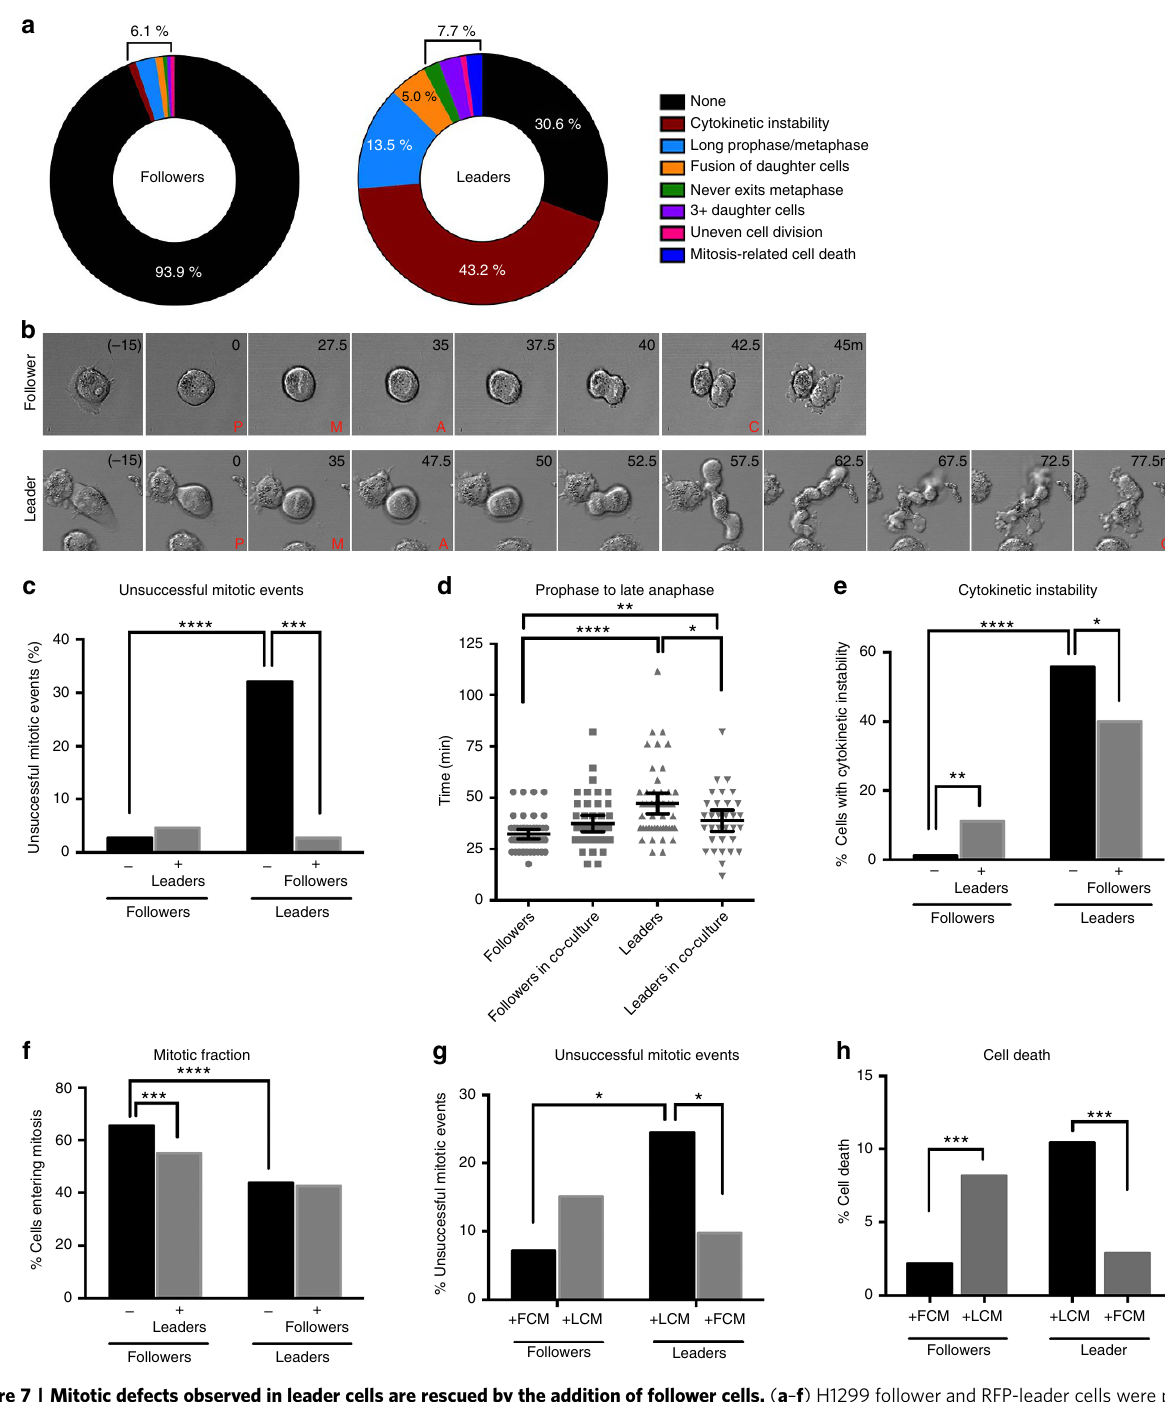
Figure 7 | Mitotic defects observed in leader cells are rescued by the addition of follower cells. ( a – f ) H1299 follower and RFP-leader cells were plated in 2D alone or in a 50:50 mixed co-culture then imaged using live cell confocal microscopy. Mitotic events were analysed in each condition. ( a ) Graphs of each type of mitotic error noted during the live cell imaging as a percentage of all mitotic events. n ¼ 258. ( b ) Still images of a mitotic event in a follower cell and a leader cell. Time in minutes. P, prophase; M, metaphase; A, anaphase; C, cytokinesis. ( c ) Unsuccessful mitotic events were classified and graphed as a percentage of total mitotic events seen in followers, leaders or each cell type in the co-culture condition. n ¼ 506. A two-tailed w 2 -test was used to determine significance. ( d ) Dot plot of the amount of time each cell spent from prophase to the beginning of anaphase. n ¼ 555 cells. A one-way ANOVA with Tukey’s multiple comparisons test was used. Bars represent the median and 95% confidence intervals from 40 randomly selected cells. ( e ) Cytokinetic instability events were graphed as a percentage of all dividing cells. A two-tailed w 2 - analysis was used. n ¼ 486. ( f ) Bar graph of mitotic fraction, defined as the number of cells that undergo mitosis as a percentage of total cells in the field of view. A two-tailed w 2 - analysis was used. n ¼ 1,106. ( g ) Unsuccessful mitotic events were counted and graphed from conditioned media from FCM or LCM. A two-tailed w 2 - analysis was used. n ¼ 185. ( h ) Leader and follower cells were cultured in LCM or FCM and cell death events were graphed as a percentage of total cells in the field of view. A two-tailed w 2 - analysis was used. n ¼ 1782. * P o 0.05, ** P o 0.01 *** P o 0.001, **** P o 0.0001.